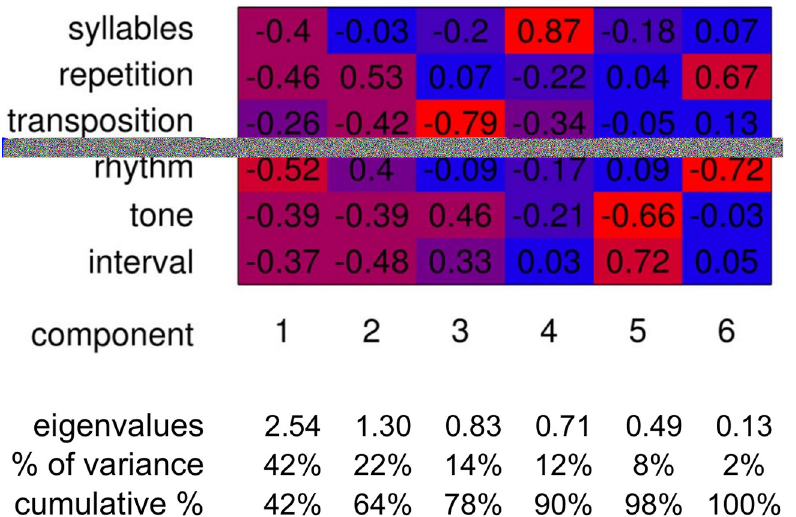
Fig 4. Results of the principal components analysis of music universals on primate calls. The PCA of structural acoustic features ( p = 6) applied to primate calls ( n = 826), suggests that repetition, transposition, and syllable count are the most distinctly explanatory of the overall variance. The feature score loadings (top) table contains each features’ correlations with each component. Red cells have high absolute loading values and blue cells are closer to zero. The variables (e.g. rhythm, tone) that are associated strongly with each rejected ( λ < 0.71) component (PC5 and PC6) were eliminated. While PC1 (signal content) is relatively homogeneous across features, the retained PC2 (degree of temporal versus spectral redundancy: 22% of total var.) distinctly partitions the six factors into three groups (see Fig